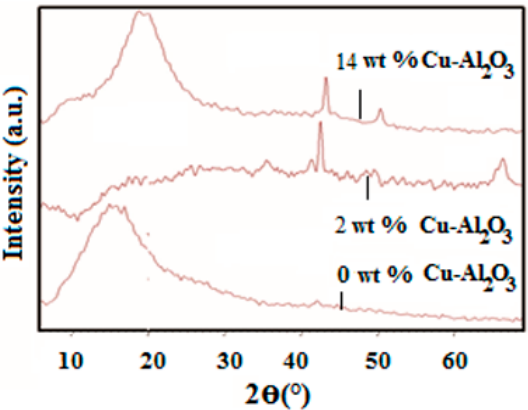
Figure 3. XRD patterns of neat polystyrene-block-poly(ethylene-ran-butylene)-block-polystyrene-graft-maleic